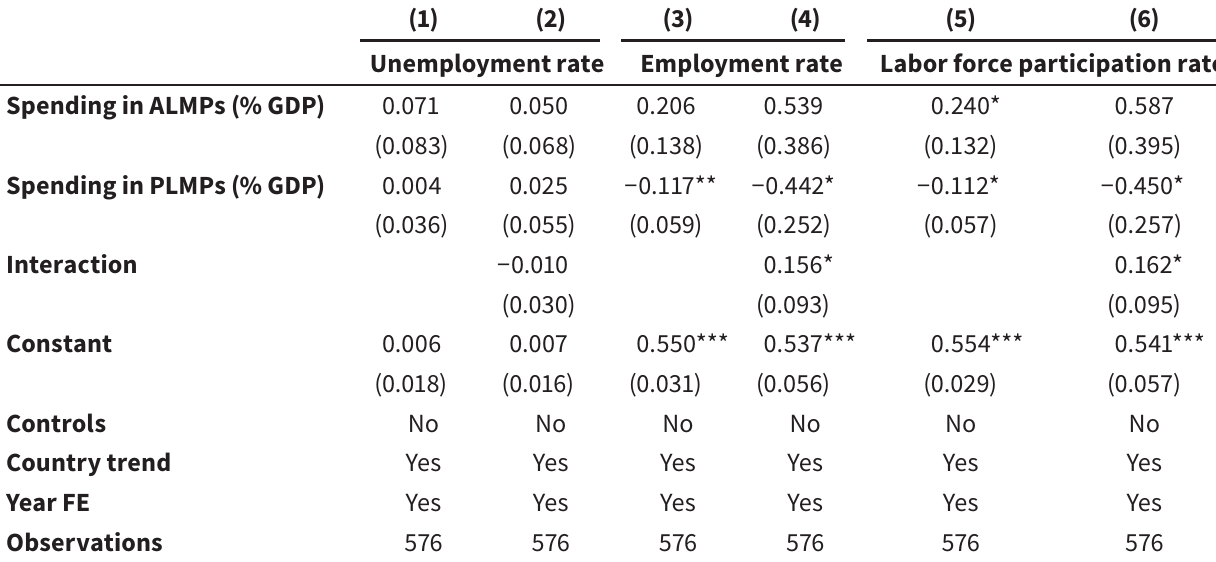
Table 7. Results for the robustness test excluding the crisis